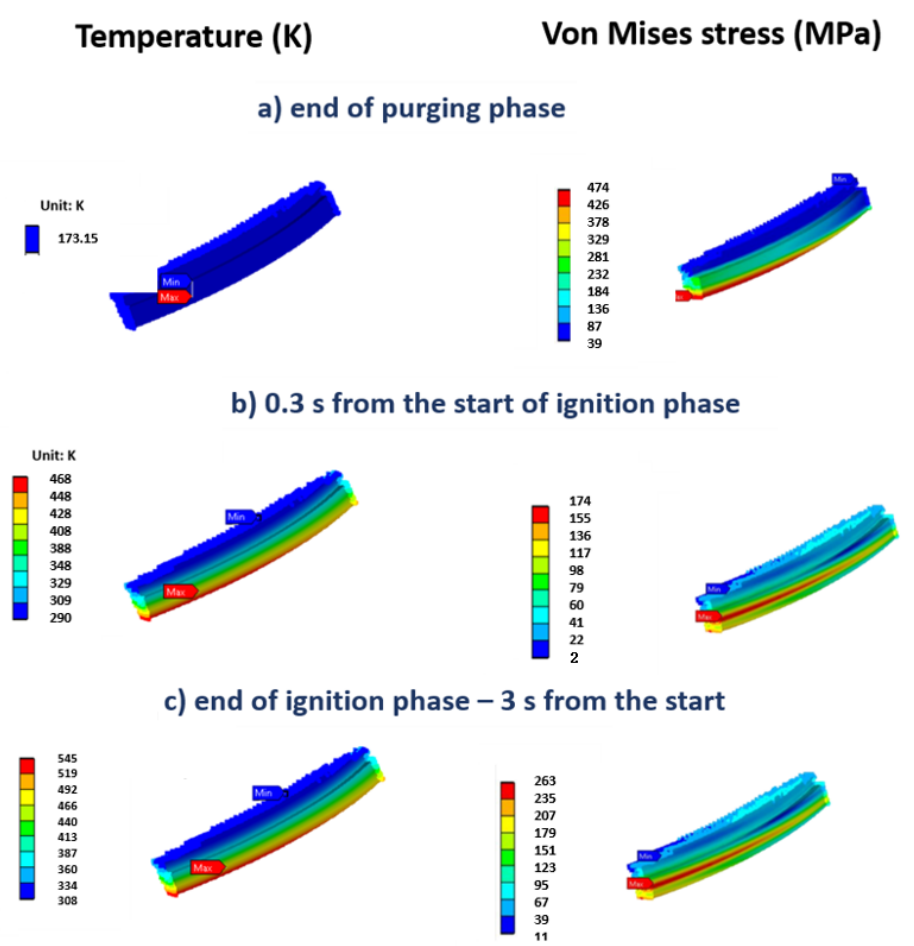
Figure 12. Temperature and von Mises stress contour plots: ( a ) end of purging phase, ( b ) 0.3 s from the start of the ignition phase, ( c ) end of the ignition phase.